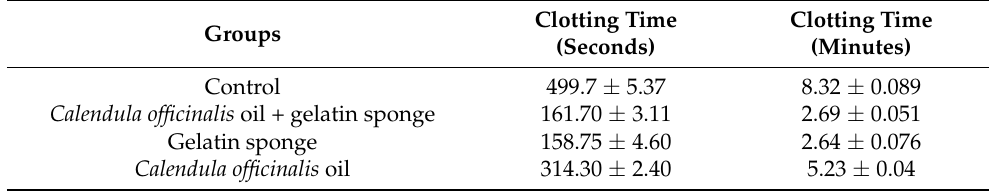
Figure 11. The bar graph result of comparison between the duration required for the blood clot formation within the 4 groups, *—showing statistically significant difference ( p < 0.001). Table 2. Clotting time assessed using Lee–White method.